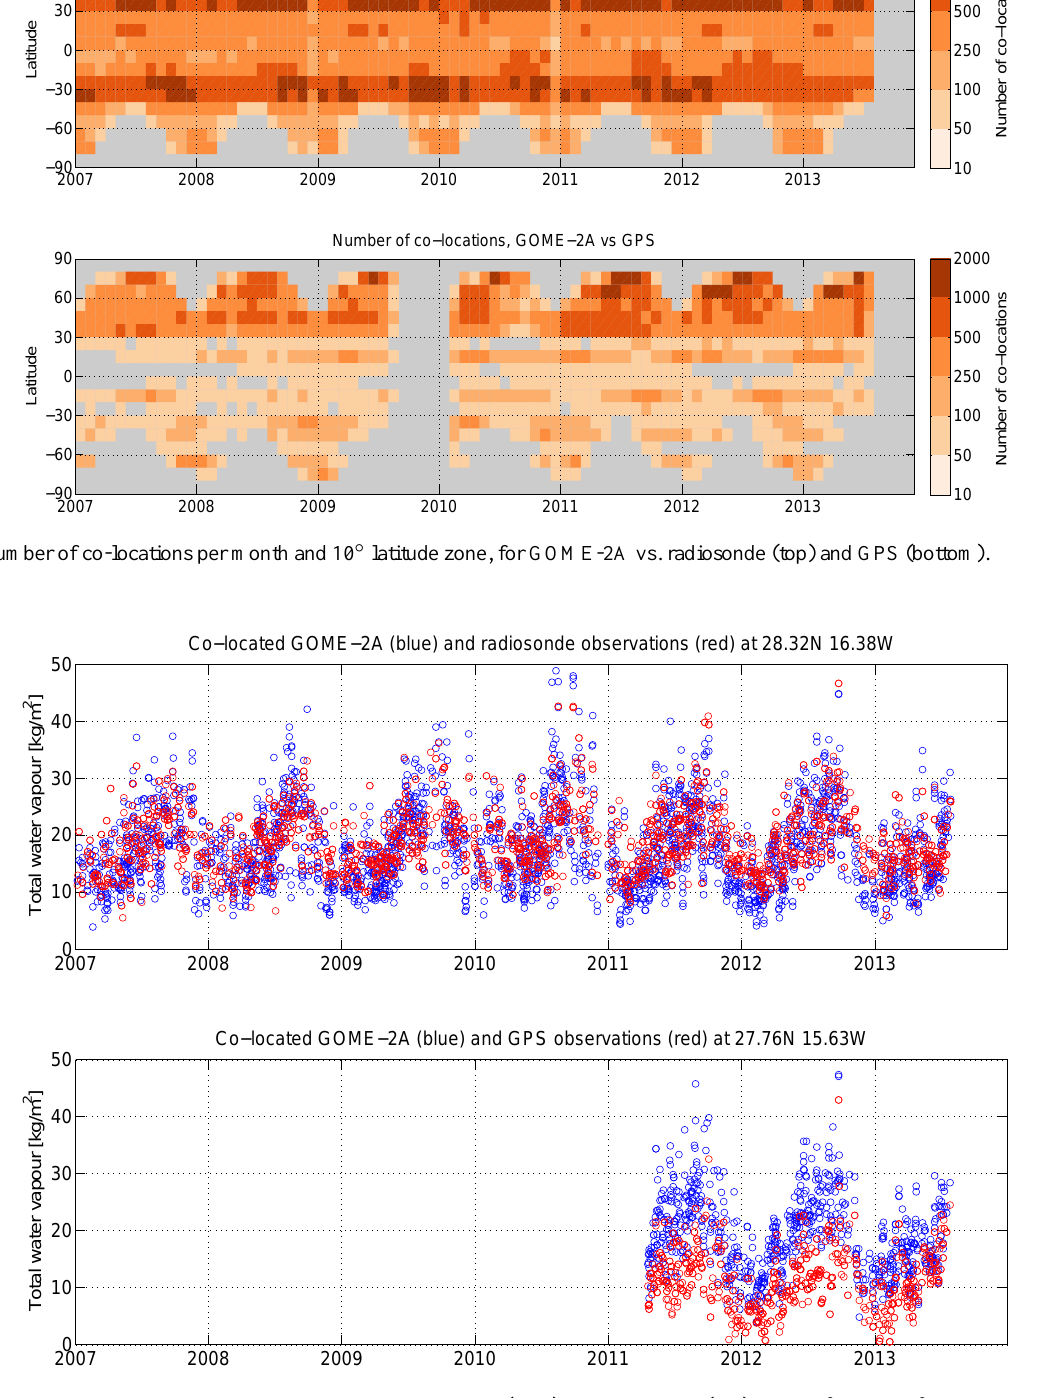
Figure 9. Top: time series of co-located observations for GOME-2A (blue) and radiosonde (red) at 28.32 ◦ N, 16.38 ◦ W. Bottom: GOME-2A (blue) and GPS (red) at 27.76 ◦ N, 15.63 ◦ W. Since the GPS network is sparser than the radiosonde network (see Fig. 1), large biases or poor temporal representativeness at individual stations can affect the biases at certain latitude bands to a larger degree than in the case of comparisons with radiosoundings (see Fig.